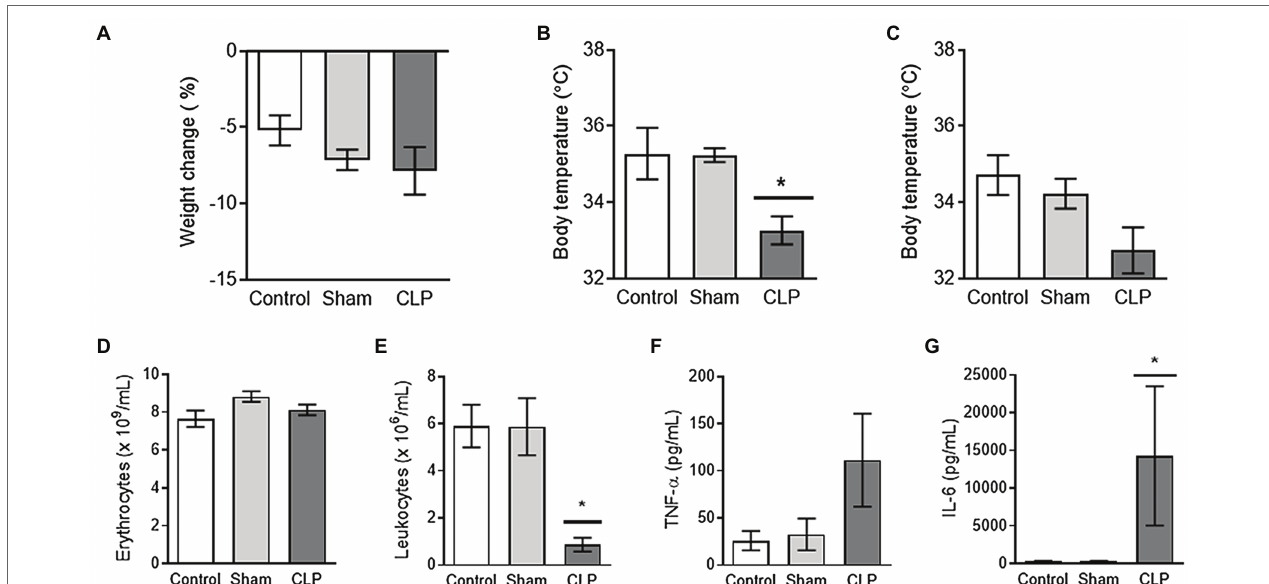
FIGURE 1 | (A–C) Sepsis leads to transient hypothermia. Mice in cecal ligation and puncture (CLP) seem to experience weight loss, which was, however, not different compared to control or sham (A) . The body temperature after induction of sepsis CLP was transiently reduced at 8 h after induction as compared to control and Sham (B) . Upon euthanization (24 h after induction), no differences were observed in body temperatures (C) . (D,E) Sepsis is associated with profound leukopenia. The numbers of erythrocytes (D) were not affected by sepsis CLP or Sham surgery. Further, sepsis CLP was associated with clearance of the majority of circulating leukocytes (E) . (F,G) Sepsis leads to increased plasma levels of proinflammatory cytokines. The induction of sepsis CLP tended to increase the level of TNF- α in plasma (F) and induced a profound rise in plasma IL-6 levels (G) . CLP: cecal ligation and puncture. * means p < 0.05, n = 7–8 mice per